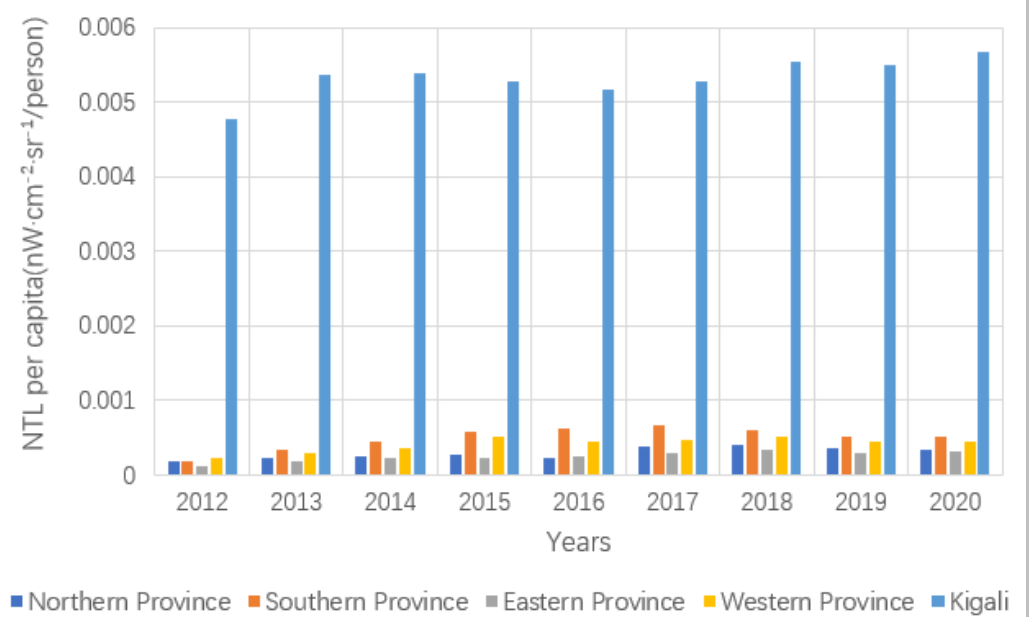
Figure 8. NTL per capita of each province in Rwanda from 2012 to 2020.